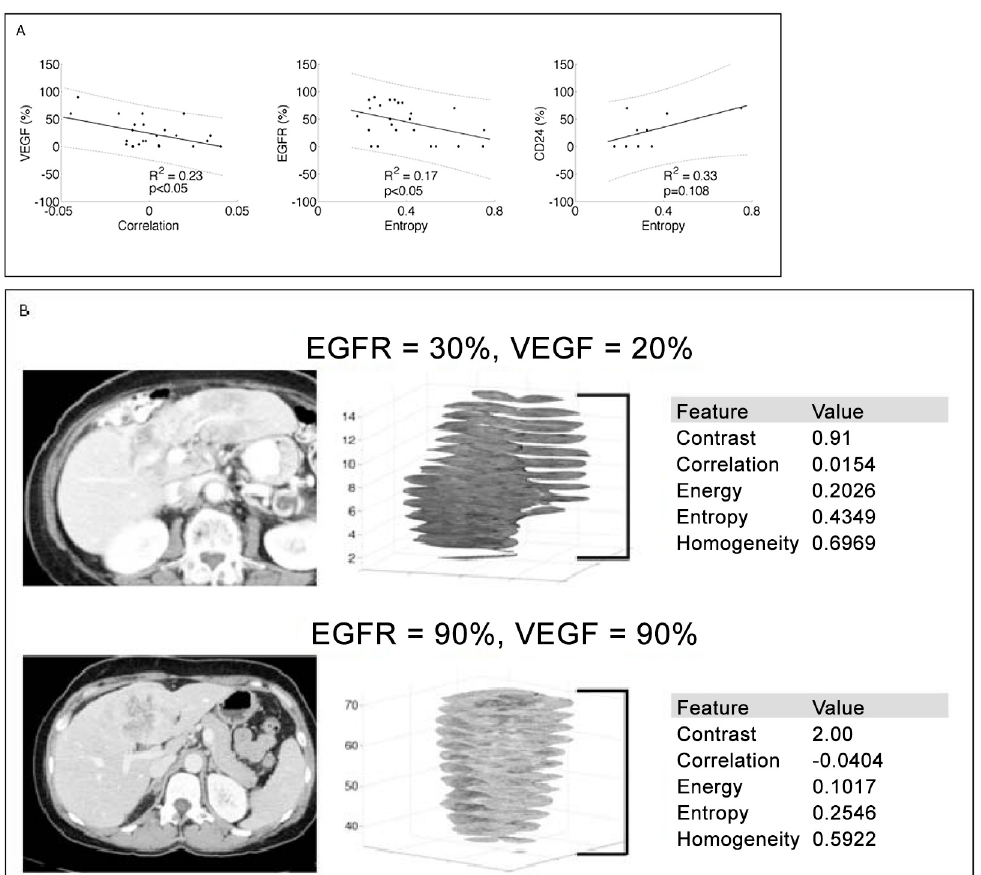
Fig 2. Selected linear regression plots of texture features with respect to protein expression levels. The 95% confidence interval is rendered. For descriptive purpose, each protein is plotted against the texture feature that contributed the most to the prediction model (A). Two intrahepatic cholangiocarcinomas with low (top row) and high (bottom row) VEGF/EGFR protein expression by immunohistochemistry. After semi-automated segmentation of tumor borders from CT images, the tumor pixel attenuation values are evaluated for texture features. Axial slices of the segmented tumors are shown with texture features calculated for each slice and averaged. (B).